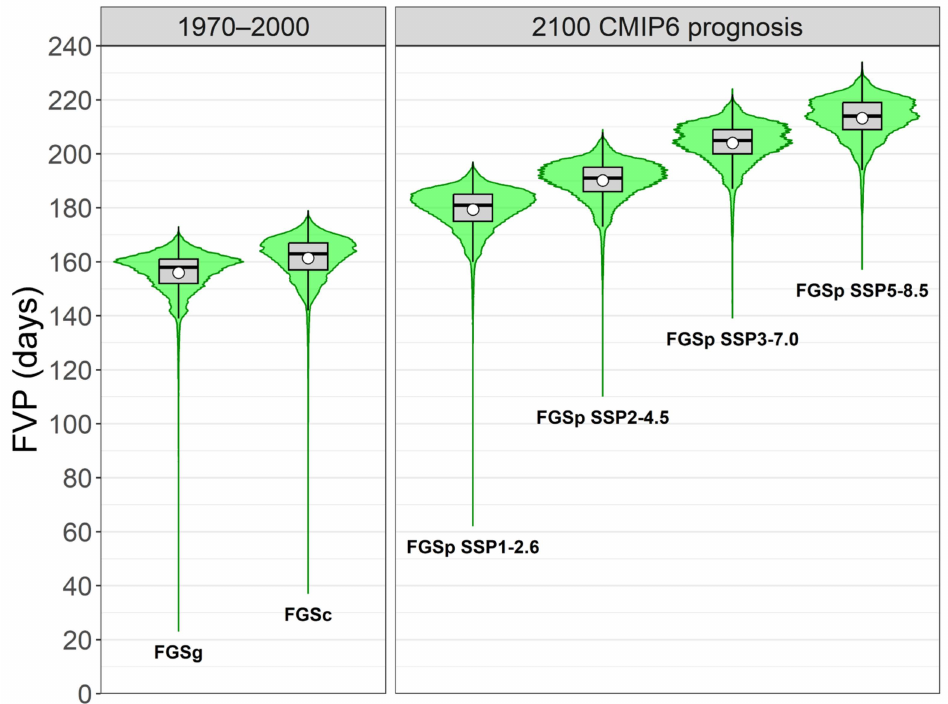
Figure 6. Box-plot charts reflecting values of FGS (grey boxes) with corresponding distributions (green area) and the mean value (white dot) calculated on the basis of WorldClim grid datasets: for the period of 1970–2000 calculated directly (FGSg), with correction model applied (FGSc) and according to tested CMIP6 climatic scenarios for the year 2100